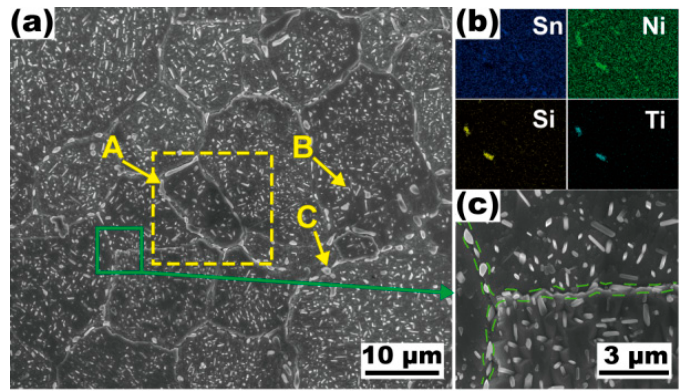
Figure 4. TEM images revealing the microstructures of Cu-15Ni-8Sn-0.3Si-0.1Ti ( a ) and Cu-15Ni-8Sn alloys ( b , c ) after annealing at 1093 K for 1 h. The inserts reveal the selected area diffraction patterns (SADP) of related particles.